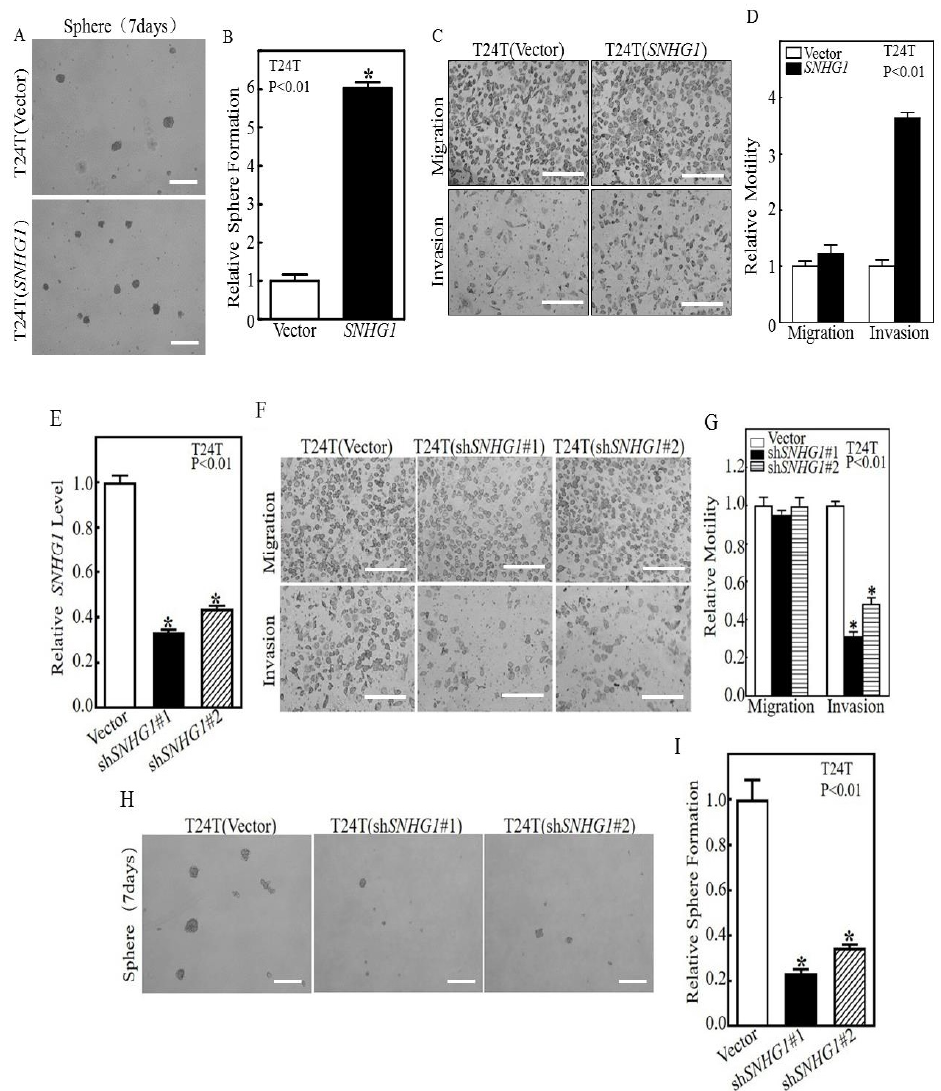
Figure 1. The over-expression of SNHG1 induced stem-cell-like sphere formation and invasion; conversely, the knockdown of SNHG1 inhibited sphere formation and invasion. ( A , B ) T24T cells stably transfected with a mock vector (T24T(Vector)) or SNHG1 (T24T( SNHG1 )) were plated into ultra-low attachment plates. After 7 days of culture, representative images of sphere colonies were photographed ( A ), and the number of tumor spheres was counted and presented relative to T24T(Vector) cells ( B ). ( C , D ) The migration and invasion of T24T(Vector) and T24T( SNHG1 ) cells were both determined using a BD BiocoatTM MatrigelTM invasion chamber. Migration was determined using the empty insert membrane without Matrigel, while invasion was evaluated using the same system except that Matrigel was applied ( C ). The invasiveness was normalized to the insert control according to the manufacturer’s instructions ( B ). ( E ) T24T cells were stably transfected with a mock vector (T24T(Vector)) or two independent shRNAs of SNHG1 , i.e., T24T(sh SNHG1 #1) or sh SNHG1 #2. The knockdown of SNHG1 is indicated with an asterisk (*) indicating significant decreases in comparison to T24T(Vector) cells ( p < 0.01). ( F , G ) The stable transfectants were assessed for their migration and invasion with the same methods as with SNHG1 over-expression. ( H , I ) T24T(Vector), T24T(sh SNHG1 #1), and T24T(sh SNHG1 #2) cells were plated into ultra-low attachment plates. After 7 days of culture, representative images of sphere-forming colonies were captured under microscopy ( H ), and the number of spheres formed was counted and presented relative to T24T(Vector) cells (B). Bars in ( A , H ) are equal to 200 μ M and equal to 100 μ m in ( C , F ).